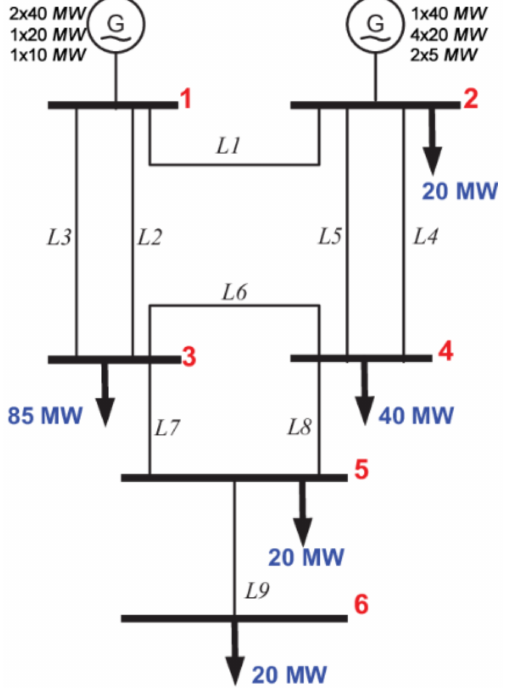
Figure 5. RBTS–IEEE study system